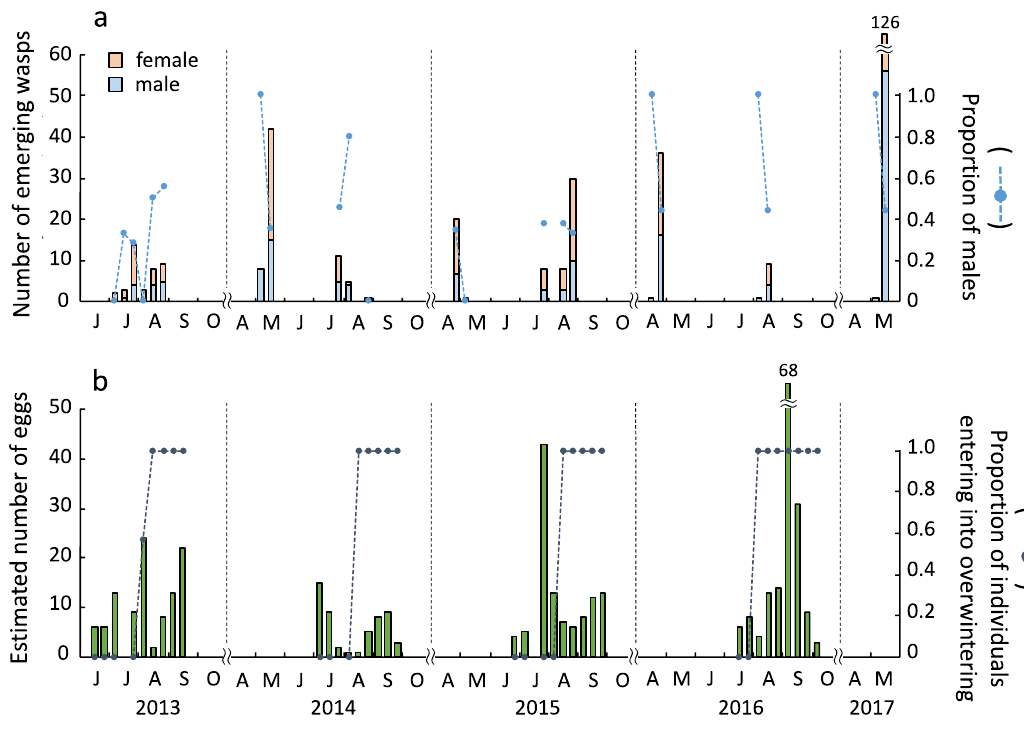
Figure 3. Seasonal changes in the numbers of newly emerging adults of Dipogon sperconsus and its eggs laid for 10 days of each month from 2013–2017. ( a ) The number of adult wasps emerging from rearing nests under room conditions (bars) and the male sex ratio of emerging wasps (blue circles) (see also Supplementary Table S13). ( b ) The estimated number of eggs laid by female wasps in nests (bars) and the proportion of the eggs that would develop into overwintering individuals among all eggs for each period (gray circles) (see also Supplementary Table